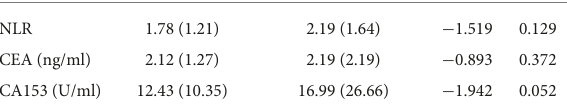
TABLE 4 Comparison of peripheral blood biomarkers (NLR, CEA, and CA153) levels in the CNG and CIG. Biomarkers CNG ( n = 44) CIG-2.293 ( n = 77)